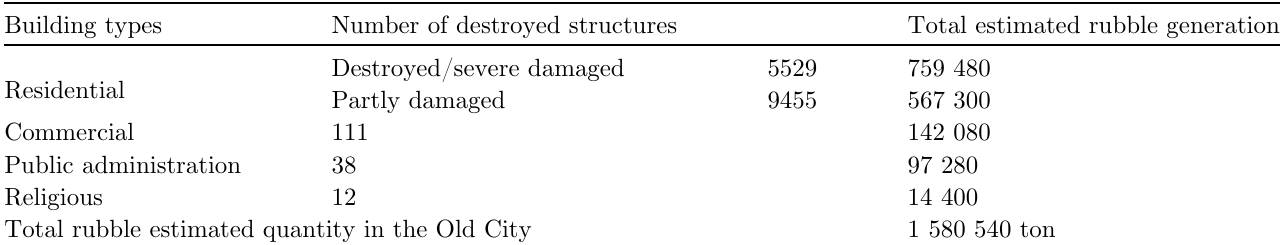
Table 3. Estimated quanti fi cation of the total rubble generated in the Old City.